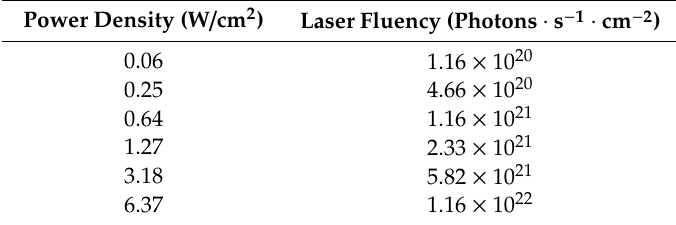
Table 1. Power density to laser photon flux conversion